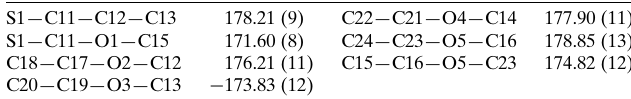
Table 1 Selected torsion angles ( (cid:3) ).